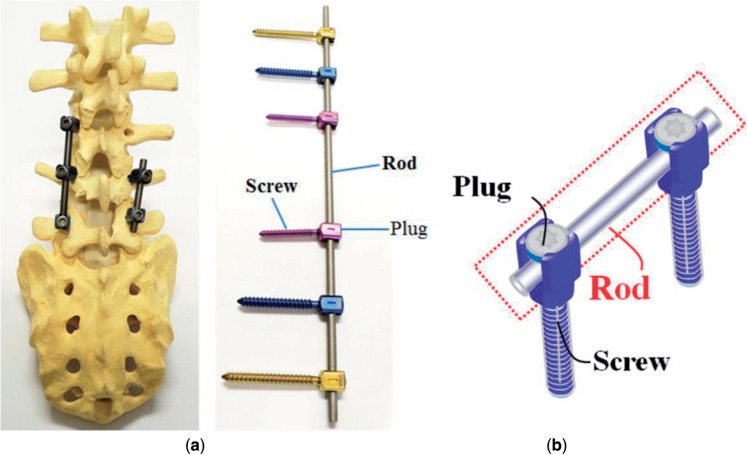
(a) Images and (b) schematic drawing of spinal fixation system consisting of rods, screws and plugs.